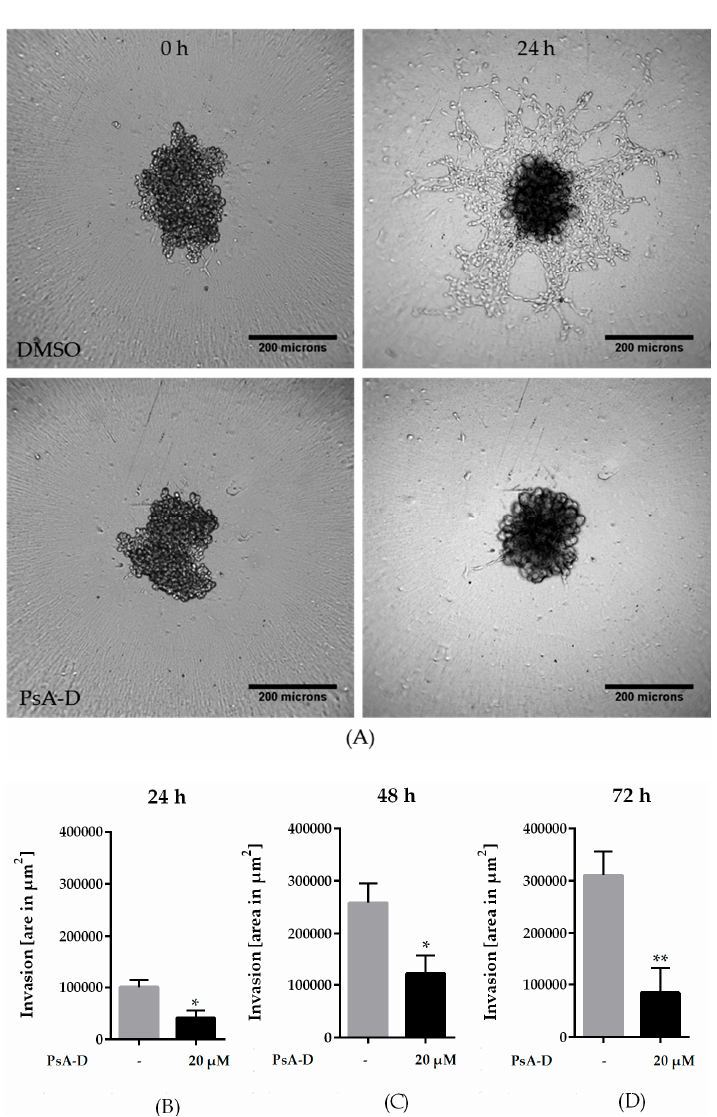
Figure 3. Pseudopterosin inhibited invasion into a 3D matrix. ( A ) Representative images of invasion of cells into a 3D matrix at the 24 h time point. Cells were imaged with IncuCyte ® ZOOM over a time range of three days. 3 × 10 3 cells per well were seeded into ultra-low-attachment (ULA) round-bottom plates and spheroids were formed for 72 h. Scale bars in black show 200 microns in length. ( B – D ) The bar diagrams show three different time points representing six independent experiments. Spheroids were treated with a concentration of 20 µM of PsA-D. Error bars were calculated using ± SEM. p -values were calculated against control (CTRL). Two stars represent a significance of p < 0.01 and one star represents a significance of p <